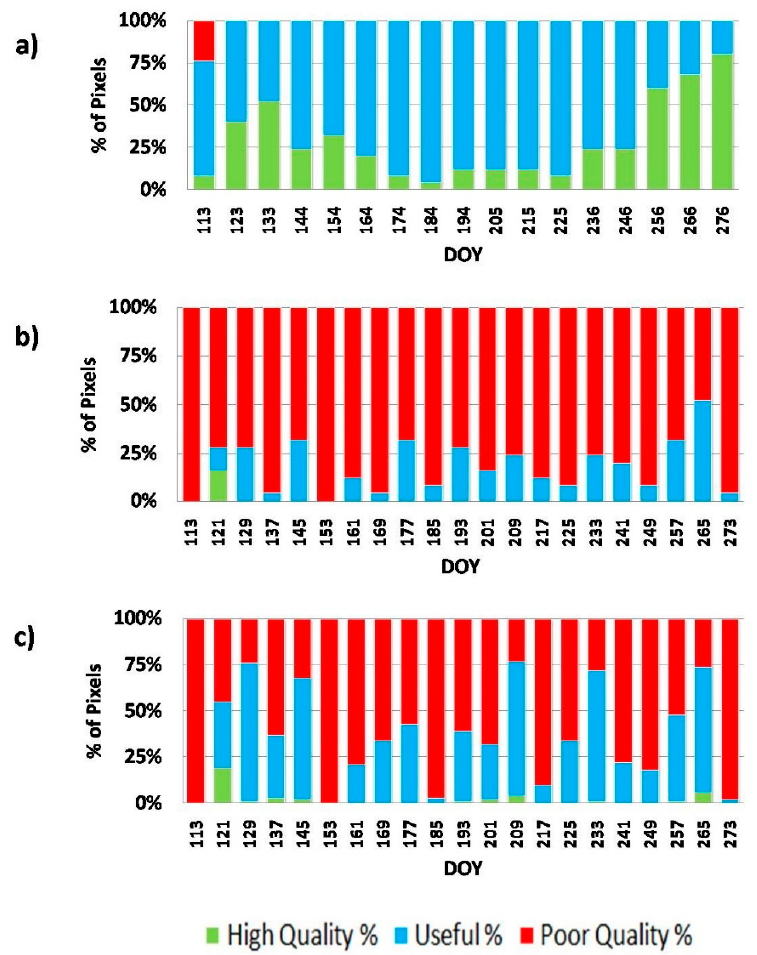
Figure 9. Quality layer information averaged over the 5 km × 5 km study area for fAPAR ( a ) PROBA-V GEOV1; ( b ) MODIS C5; and ( c ) MODIS C6 over the peak season in 2015 (DOY = Day of Year).